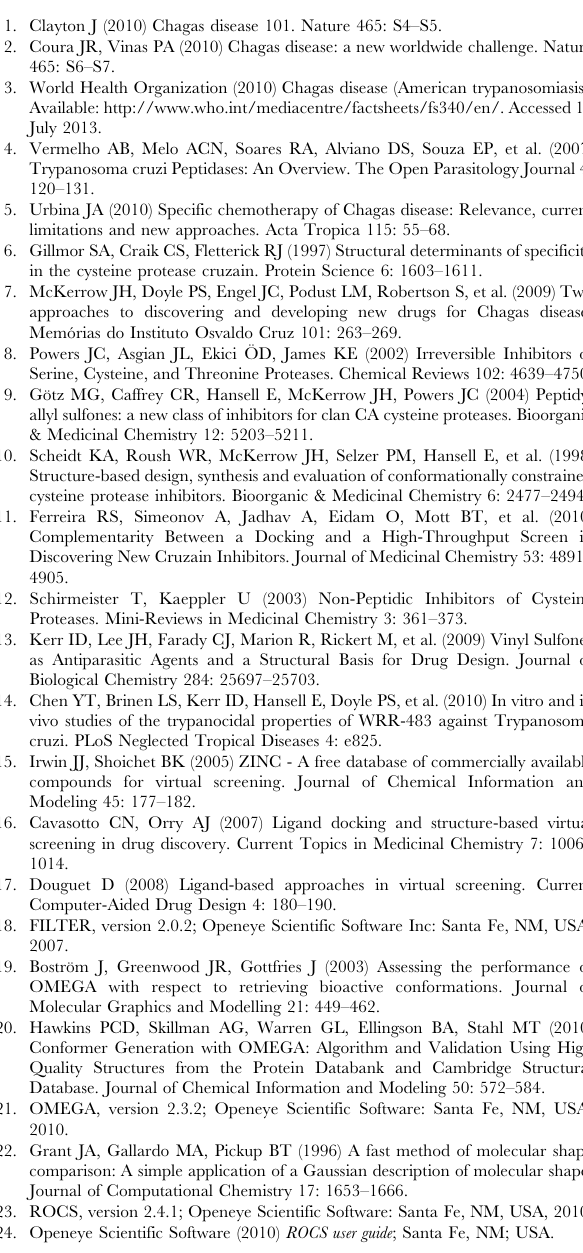
Table S1 2D structure representation, K i and IC 50 of the compounds assayed against cruzain and cathepsin L